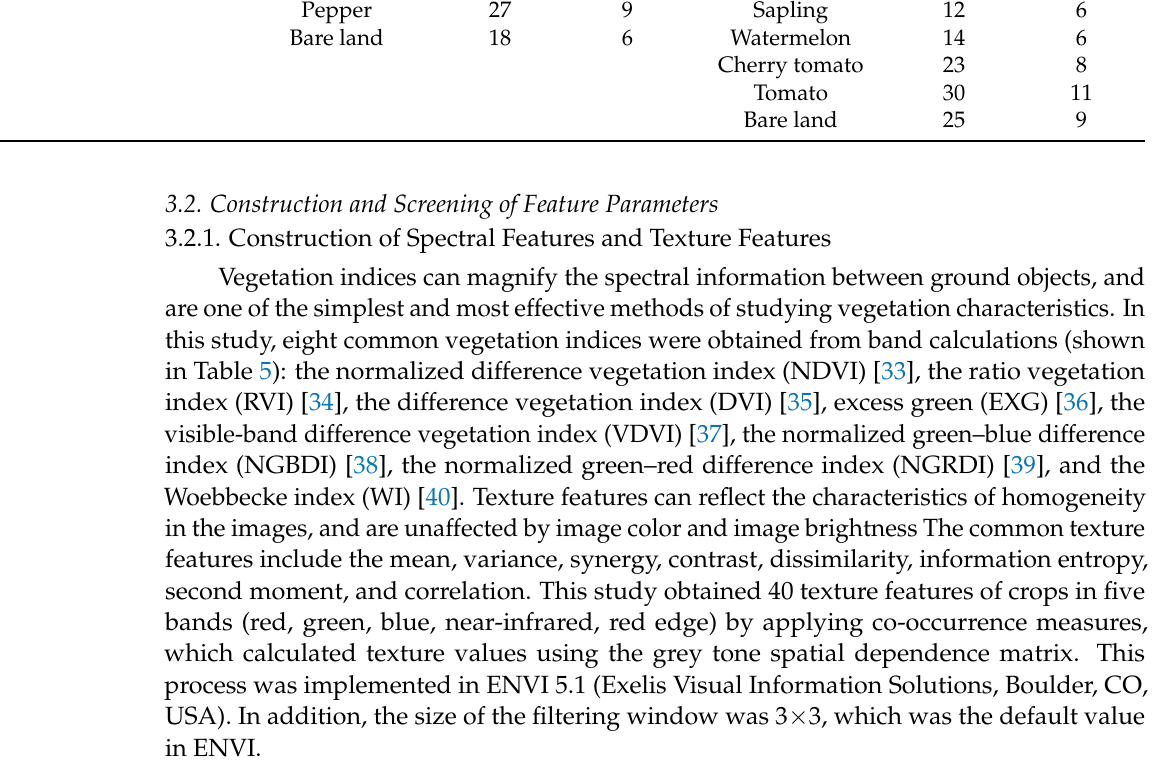
Table 5. Common vegetation